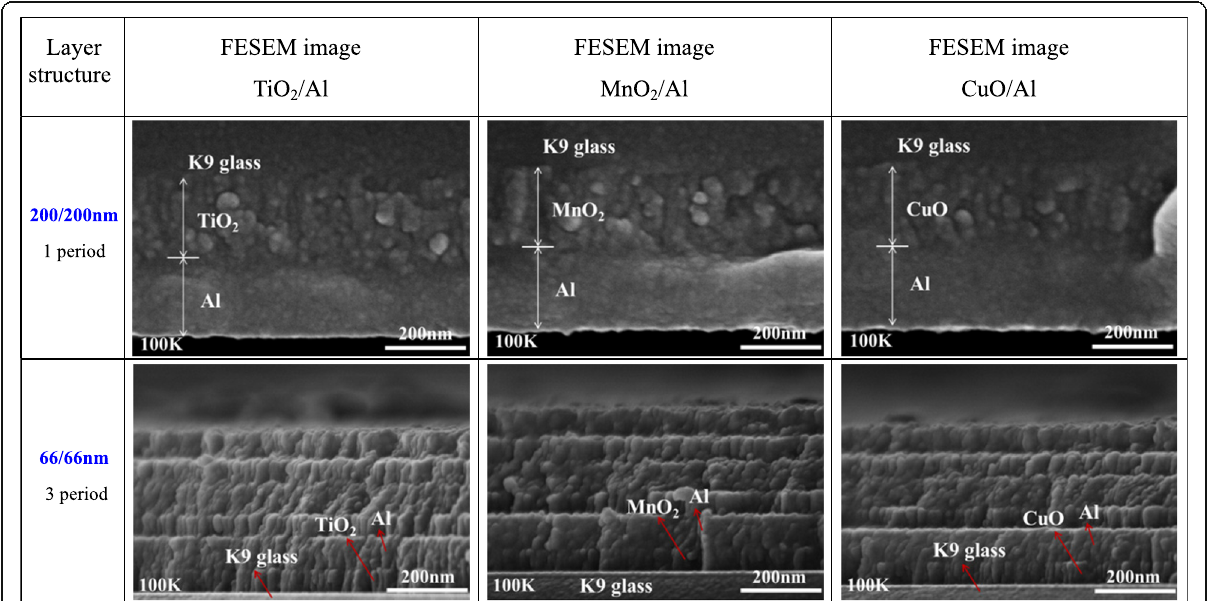
Fig. 2 The cross-sectional FESEM images of the different integrated RMFs on the K9